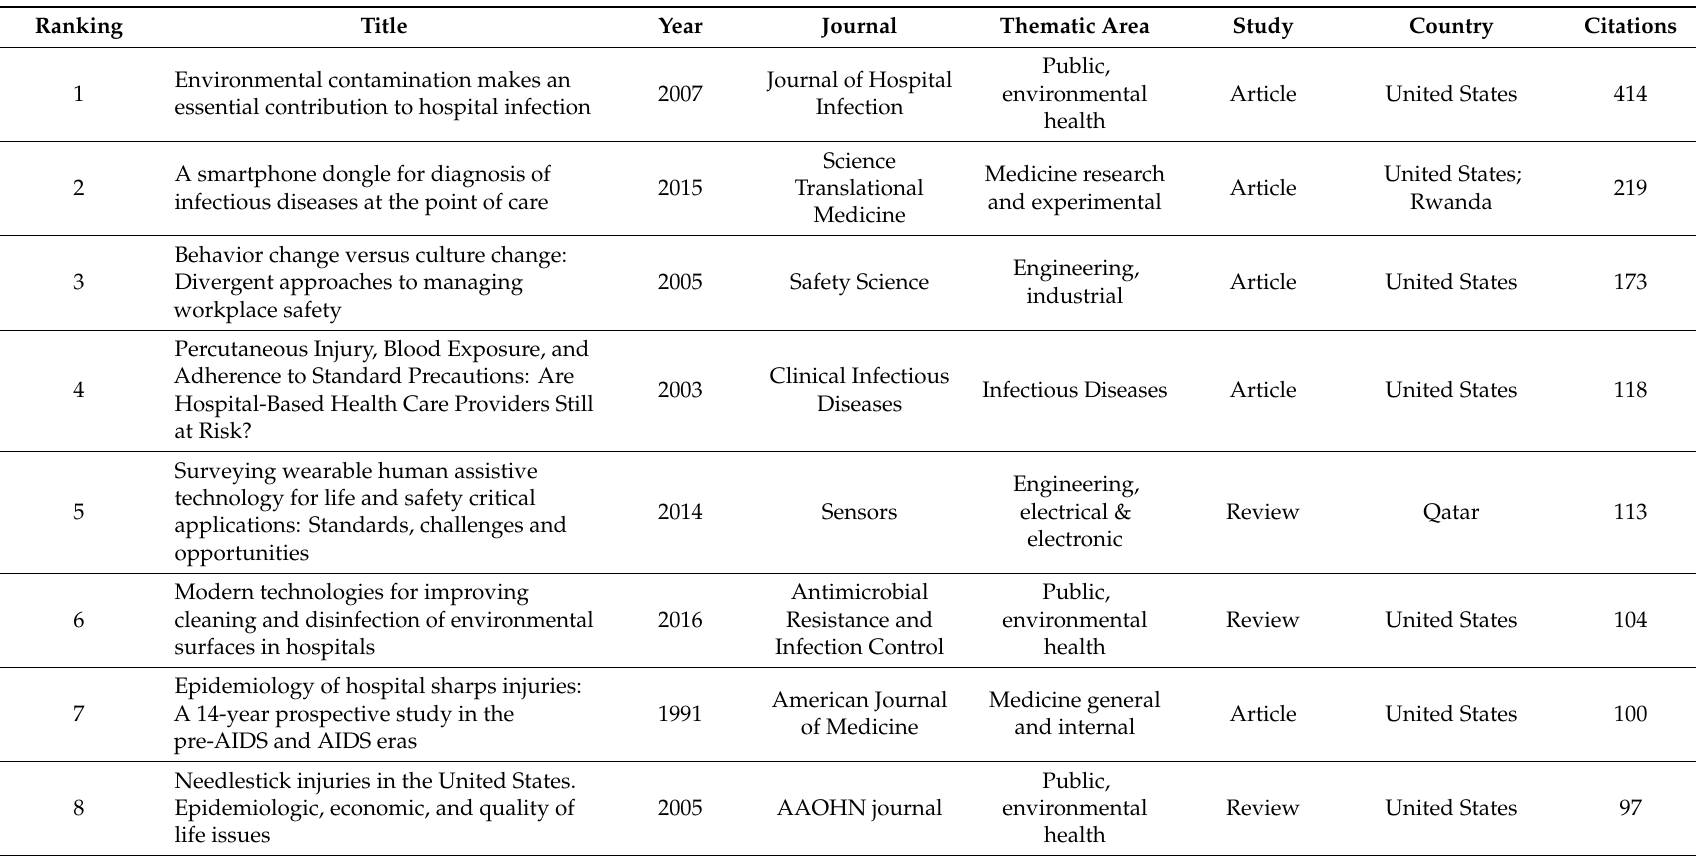
Table 3. The top ten most cited